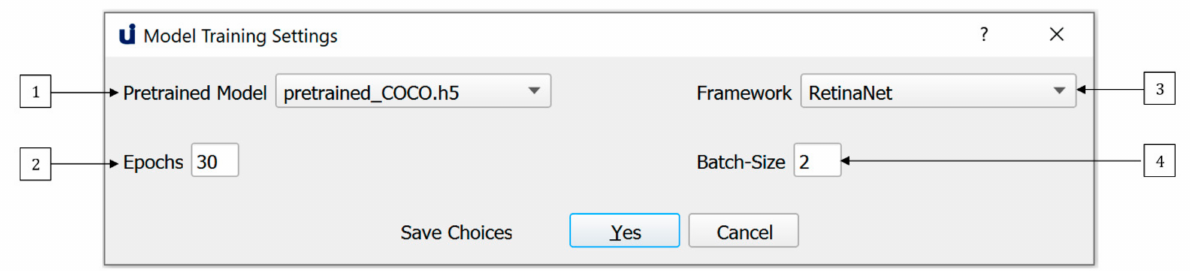
Figure 6. Default training parameters are provided however users may elect to modify these depending on their GPU capabilities and dataset